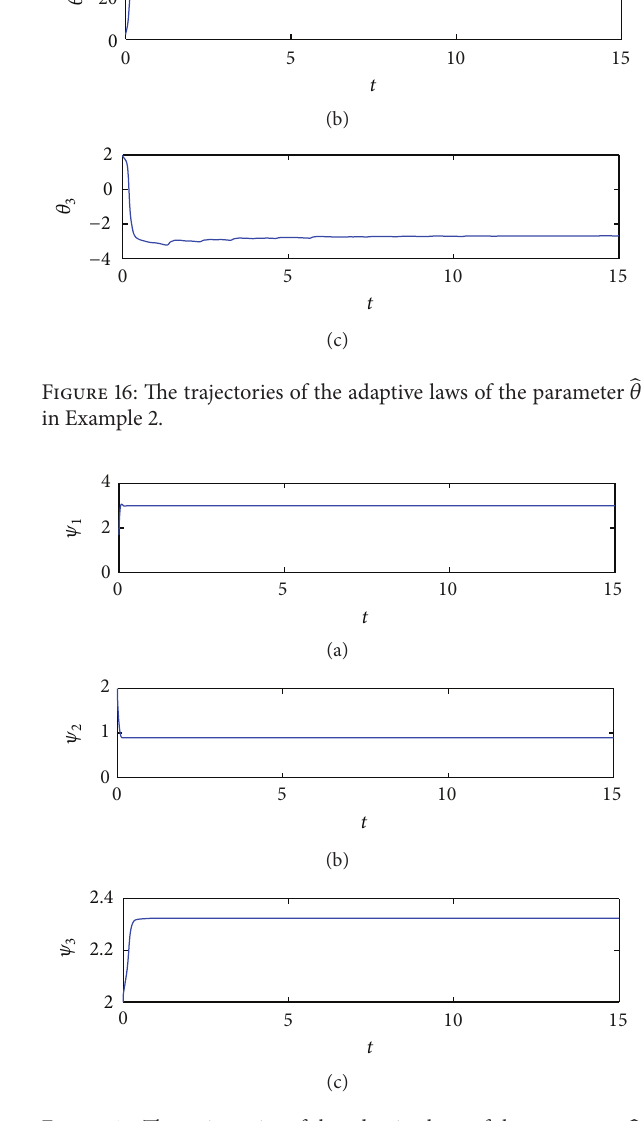
Figure 15: Time responses of the sliding mode surface 𝑠(𝑡) in Example 2.